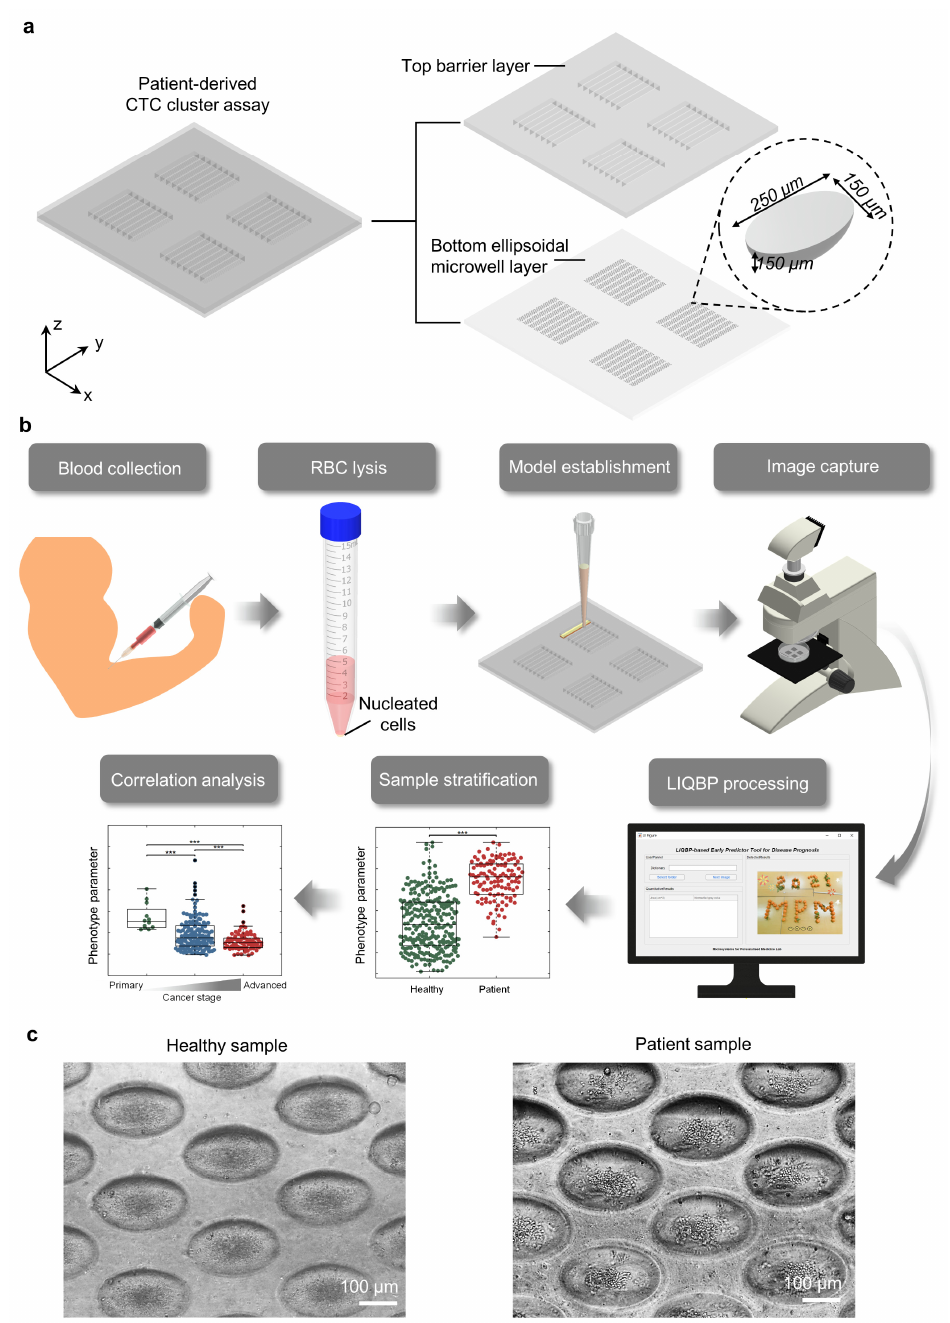
Figure 1. Using a patient-derived tumour model from a liquid biopsy (LIQBP) with multiple phenotyping for label-free prediction of disease prognosis. ( a ) Schematic illustration of the multiplexed tumor model with four units. The model was established within a microfluidic device with a top barrier layer and a bottom ellipsoidal microwell layer. Each array had eight channels comprising 300 microwells each. ( b ) Workflow for the establishment of tumor models. Peripheral blood was collected from the vein of the patient. The blood sample was lysed to remove red blood cells, and the remaining nucleated cell fraction was seeded for culturing over 14 days. Images of cultured cells were captured by a phase-contrast microscope and analyzed via LIQBP for sample stratification, with a clear distinction between patient and healthy samples. The clusters could be classified as four core phenotypes, covering the parameters of cluster size, thickness, roughness, and TA. *** Represents p ≤ 0.001. ( c ) Representative grayscale images to demonstrate the distinct morphological differences between clusters established from healthy donors ( left ) and cancer patients ( right ). Scale bar, 100 µ